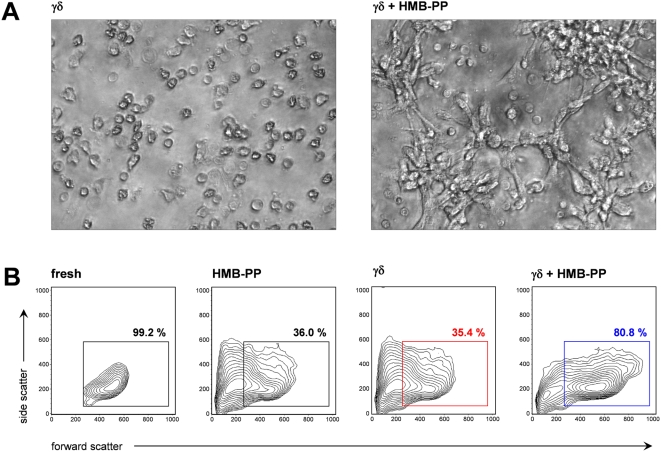
Vγ9/Vδ2 T cells promote monocyte survival and morphological changes.(A) Microscopic analysis of monocytes co-cultured for 18 hours with γδ T cells in the absence or presence of HMB-PP, representative of three individual donors. (B) Flow cytometric analysis of freshly isolated monocytes, or monocytes cultured in the presence of HMB-PP, γδ T cells, or γδ T cells+HMB-PP for 42 hours. Data shown are forward and side scatters of all CD3-negative cells, and are representative of three individual donors.